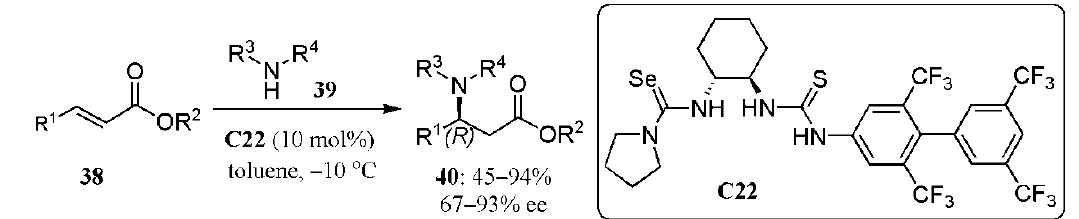
Figure 27. Synthesis of β -amino esters 40 with C22 as catalyst [58].